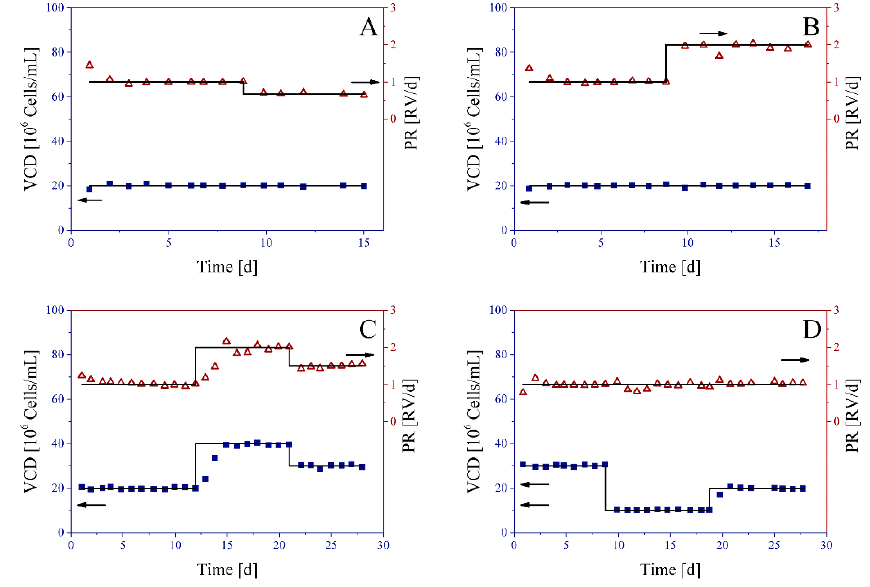
Figure 3. Perfusion cell culture experiments. Four perfusion cell culture experiments, labeled ( A ), ( B ), ( C ) and ( D ), were conducted with varying VCD and PR given set-points (solid lines). The experimental VCD and PR are shown as blue filled squares and red empty triangles, respectively.